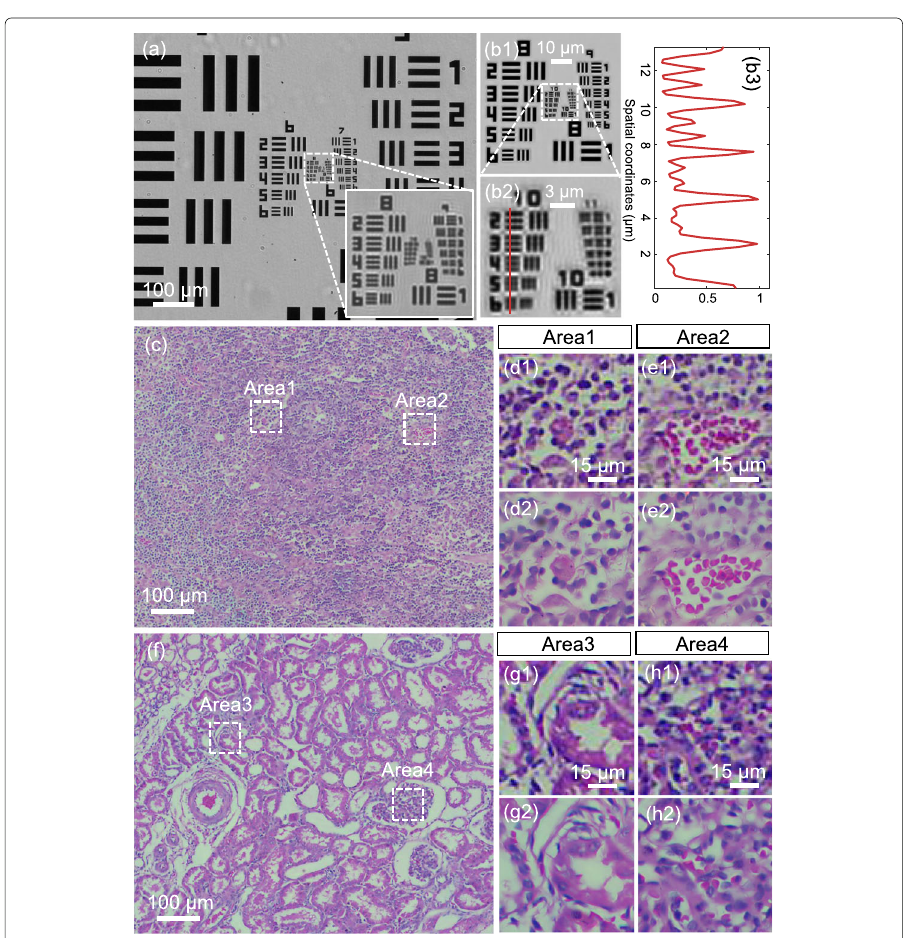
Fig. 15 High-throughput (wide field and high resolution) imaging results of USAF absorption target and stained tissue sections (human lung tissue section and human kidney vessel cells) reconstructed by FPM. (a) Full FOV low-resolution image of USAF target under bright field. (b1), (b2) The sub-region images of reconstructed high-resolution image. (b3) The intensity quantitative profile of the red line in (b2). (c), (f) Full FOV low-resolution image of stained human lung tissue section and human kidney vessel cells under bright field. (d1), (e1), (g1), (h1) The sub-region images of low-resolution image. (d2), (e2), (g2), (h2) The